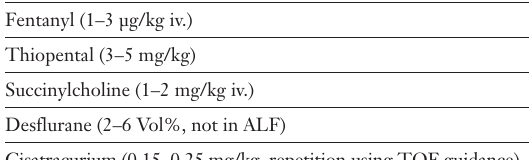
When patients are awake and responsive, appropriate criteria for extubation in fast track anaesthesia are: Criteria for imme-